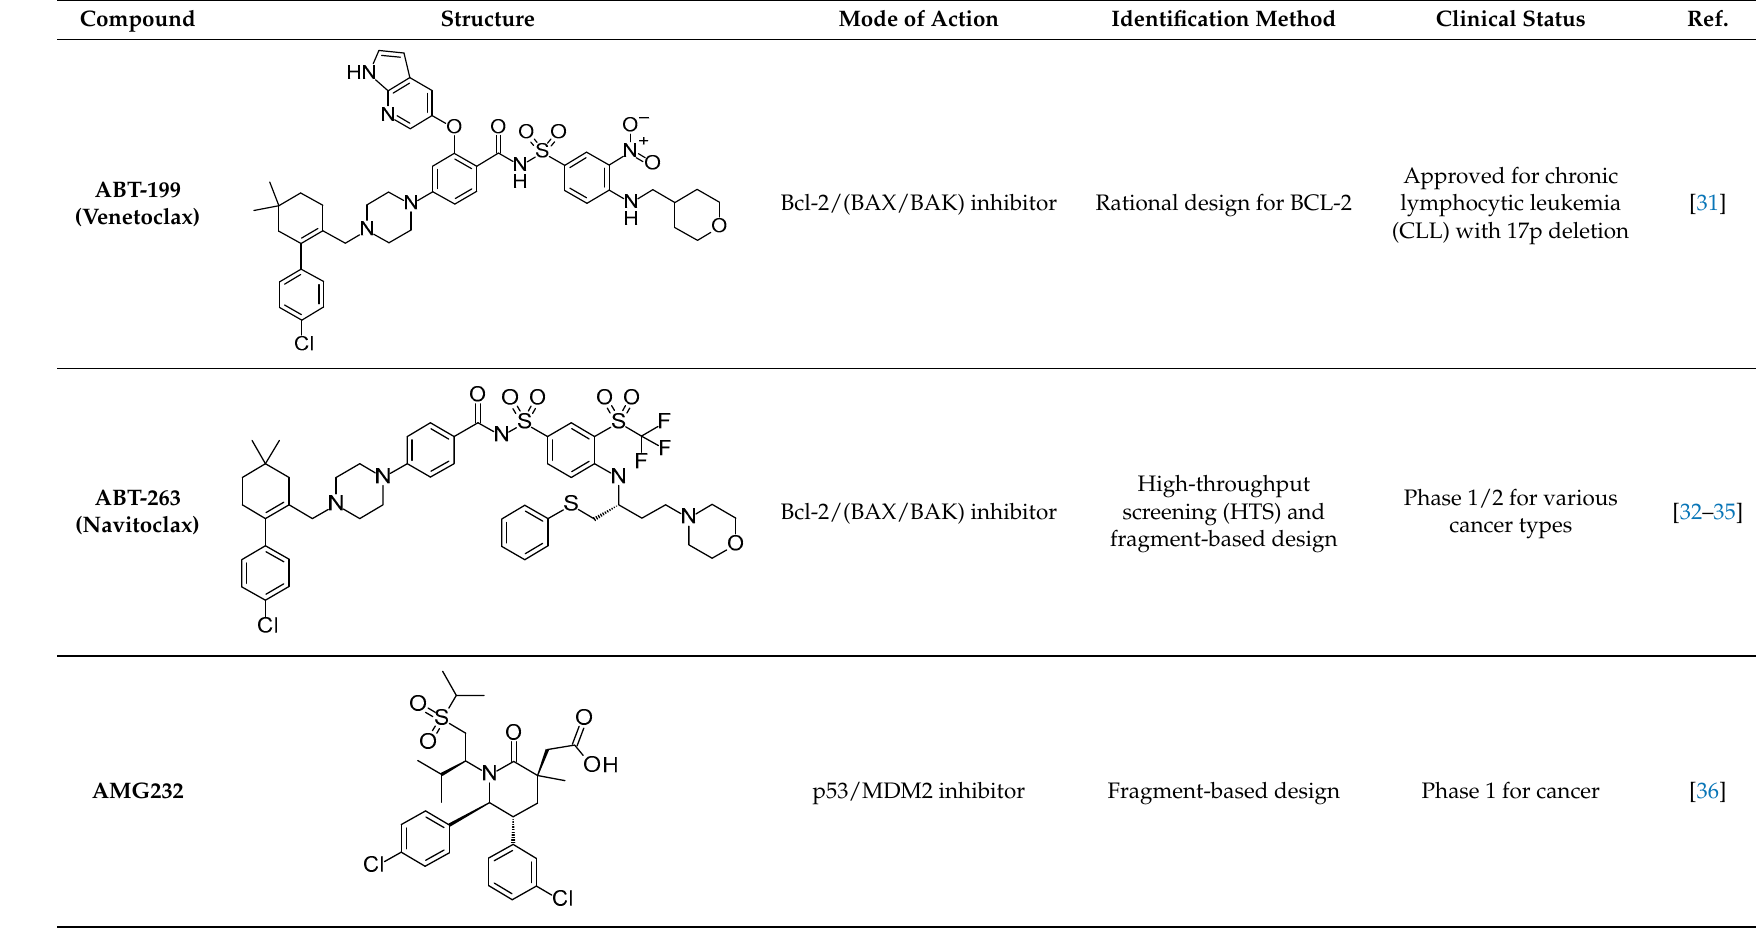
Table 1. Examples of protein-protein interaction (PPI) modulators in clinical trials or clinical use. Table 1. Examples of protein ‐ protein interaction (PPI) modulators in clinical trials or clinical use. Table 1. Examples of protein ‐ protein interaction (PPI) modulators in clinical trials or clinical use. Table 1. Examples of protein ‐ protein interaction (PPI) modulators in clinical trials or clinical